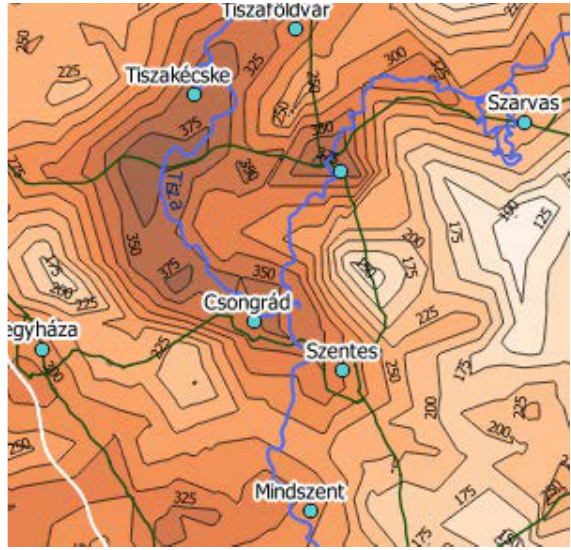
Figure 18. The Danube–Tisza Interfluve and